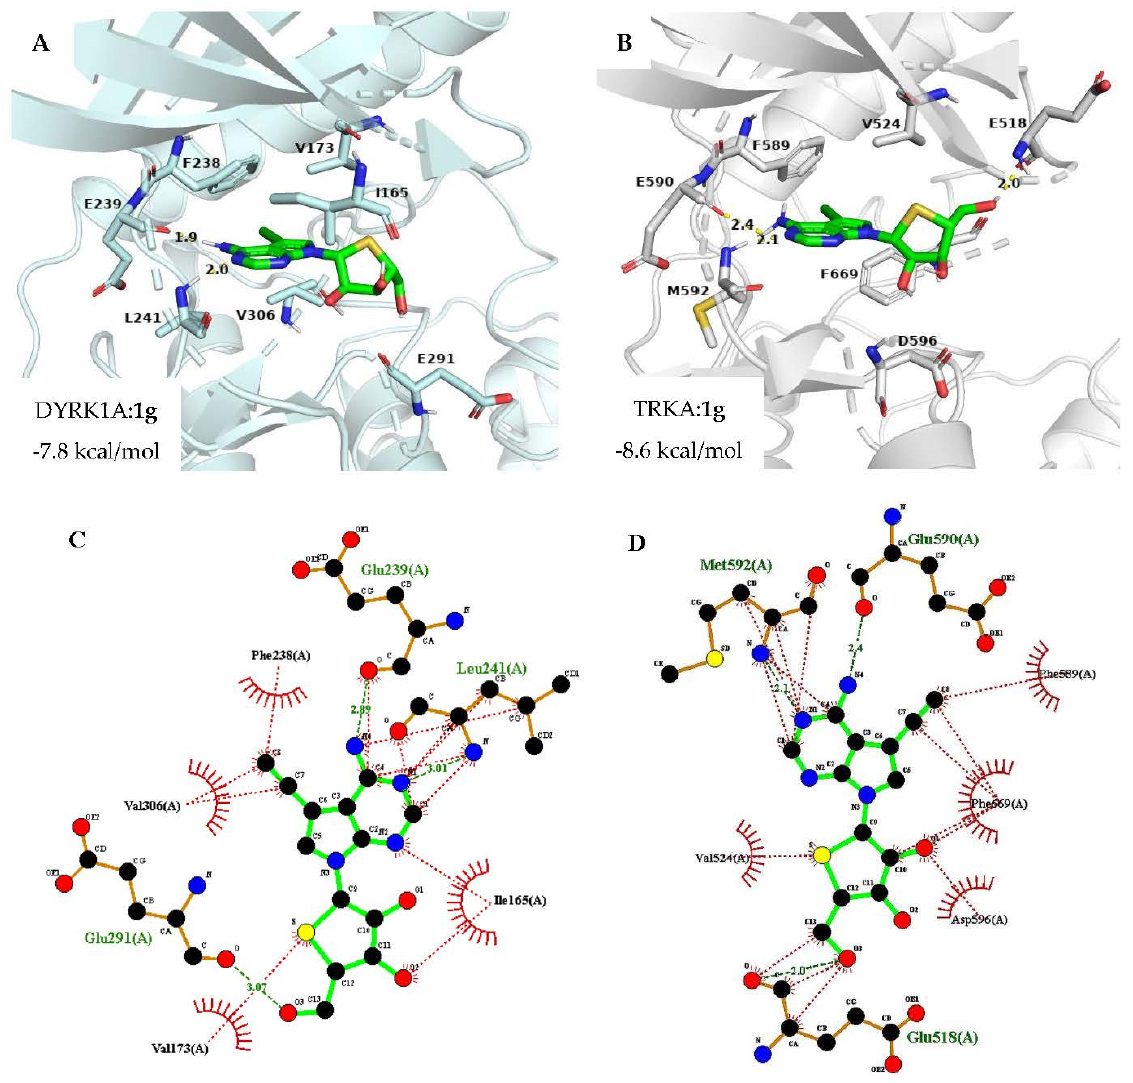
Figure 4. ( A ) Proposed binding mode of 1g (represented in green) in the ATP binding site of ( A ) DYRK1A (represented in pale cyan; PDB ID: 7A51). ( B ) TRKA (represented in gray; PDB ID: 5JFV). Hydrogen bonding is represented as yellow dashed lines. Non-polar hydrogen atoms are omitted. ( B ) 2D interaction diagram of 1g (represented in green) with ( C ) DYRK1A amino acid residues. ( D ) TRKA amino acid residues.